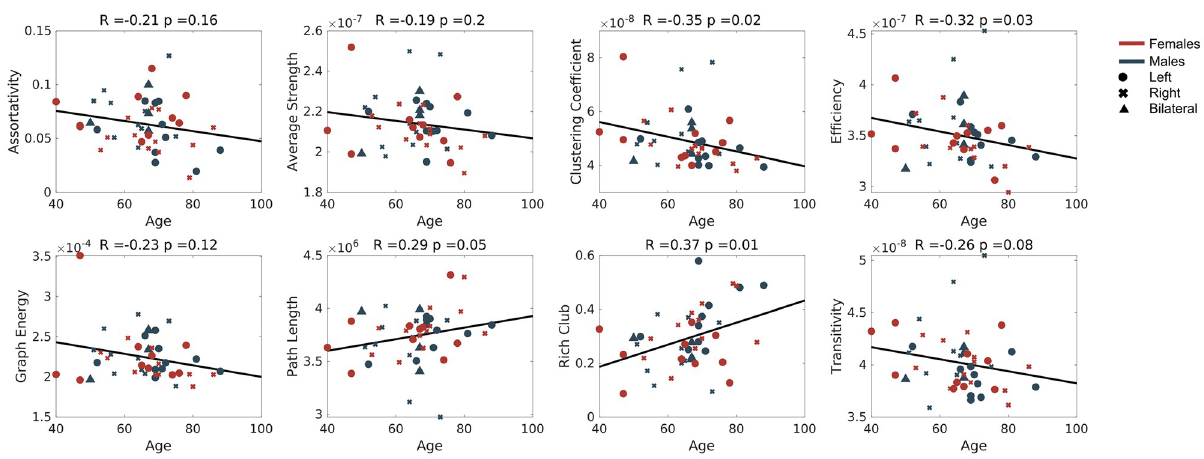
Fig 4. The relationship of age and the graph-related measures. Scatter plots of the graph-theoretical measures computed from the structural connectivity matrices of all subjects. Subjects are visually stratified according to sex (colour) and the lesion location (marker).